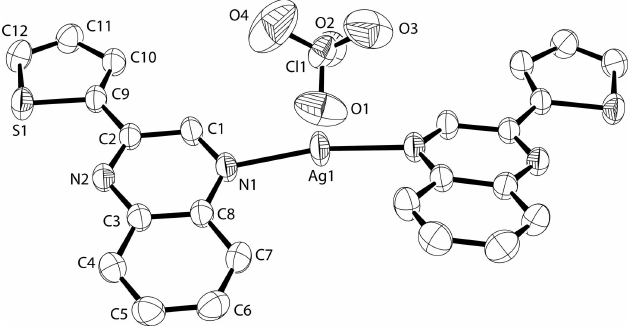
Figure 1 A view of the title compound (Farrugia, 2012). Displacement ellipsoids are drawn at the 50% probability